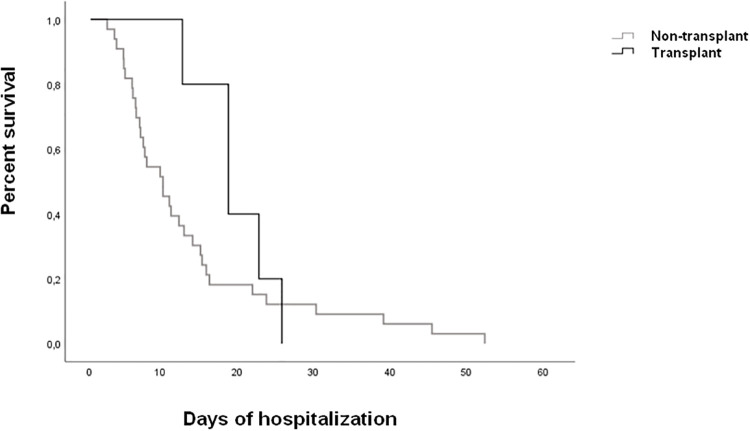
Kaplan-Meier analysis by transplant.